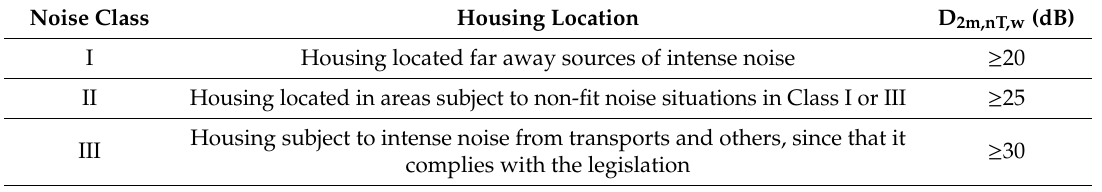
Table 1. Minimum values of D 2m,nT,w , for bedrooms [15].